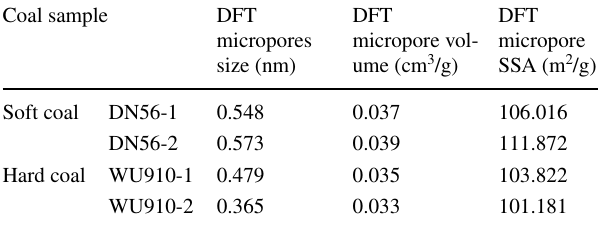
Table 3 Pore size distribution, pore volume, and SSA obtained by CO 2 -adsorption test Coal